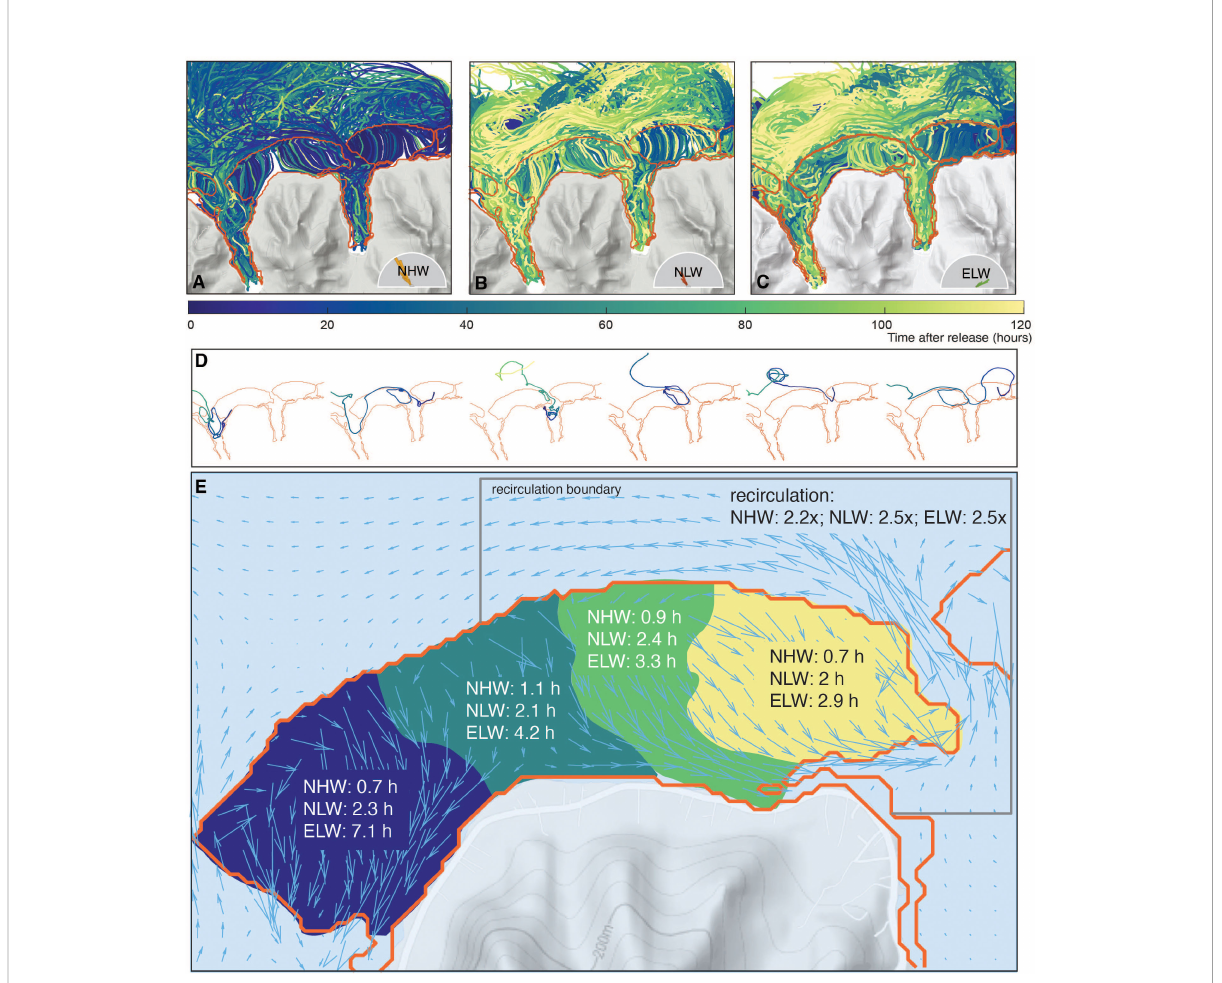
FIGURE 11 Circulation and fl ows over the reef system diagnosed from the Lagrangian simulations: Trajectories of all particles for the NHW wave regime (A) , NLW wave regime (B) and ELW wave regime (C) . Color indicates the time passed since the release. (D) Trajectories of selected particles. Colors are as in (A-C) . (E) Diagnosed transit times over different sections of the Viapahu reef for the different wave regimes. Also shown are the number of times the average water parcel passes over the reef before it leaves the recirculation boundary delineated by the black line. The arrows in (E) depict the average fl ow in the NHW wave